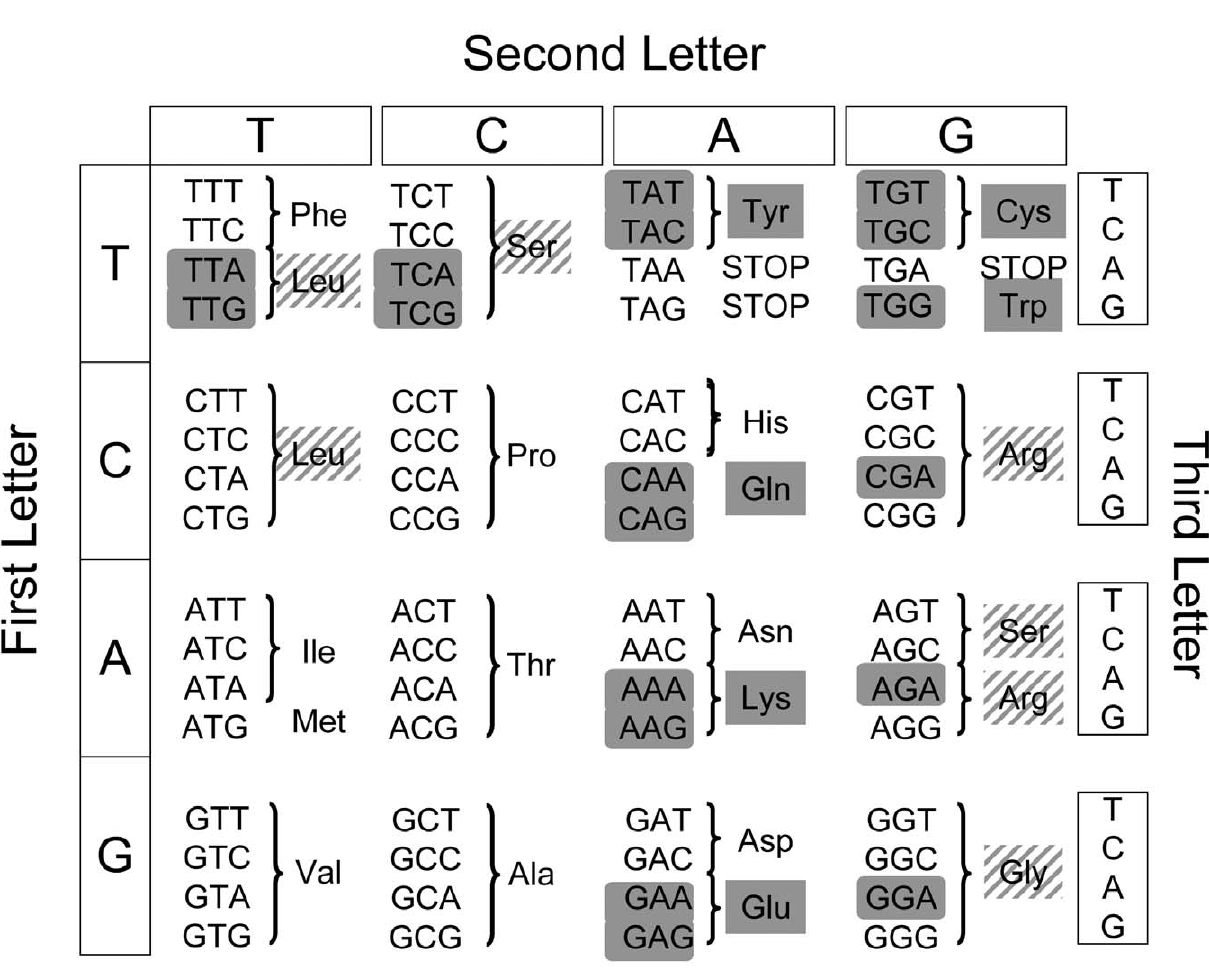
Figure 1. Sense codons differ in their propensity for conversion to STOP codons. The Standard Genetic Code contains 18 fragile codons (shaded) that can be changed into a STOP codon by a single point-mutation and whose mistranscription can therefore generate nonsense errors. The remaining 43 sense codons are ‘‘robust’’ to such errors. Six amino acids are encoded exclusively by fragile codons (‘‘fragile amino acids’’, shaded), ten amino acids are encoded exclusively by robust codons (‘‘robust amino acids’’, unshaded) and four amino acids can be encoded either by robust or fragile codons (‘‘facultative amino acids’’, hatched shading).